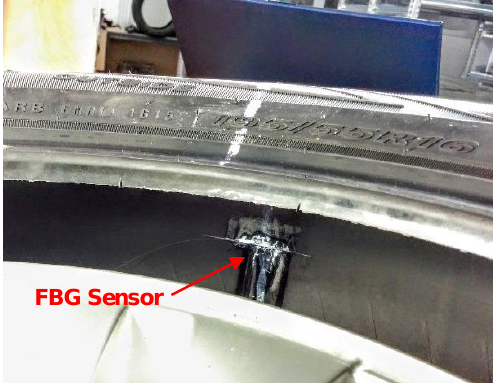
Figure 2. FBG sensor glued on the carcass of the tire.